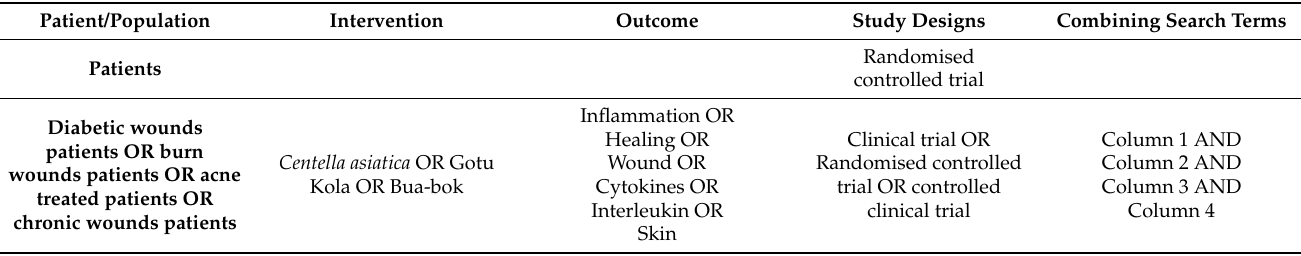
Table 1. Search Terms and Search Strategy.